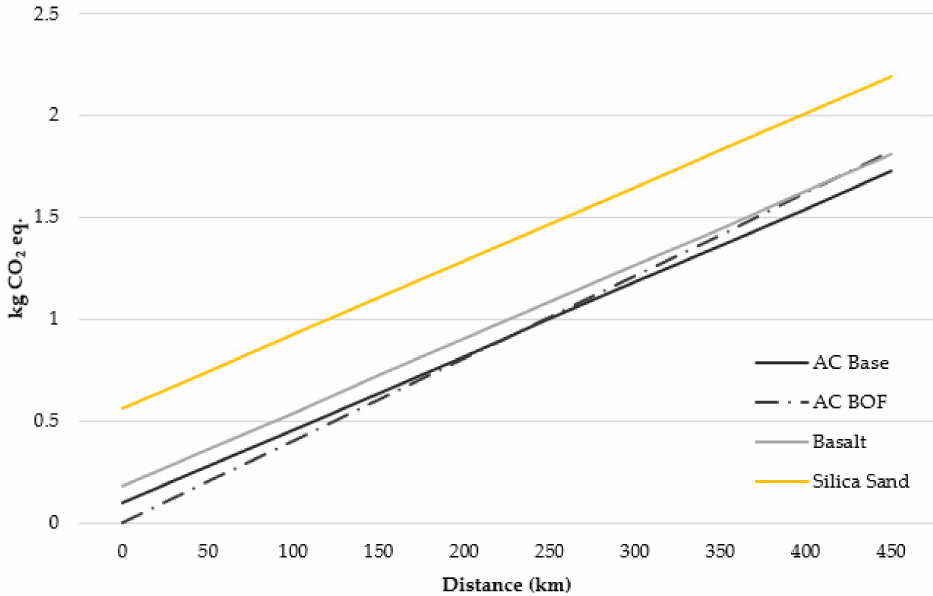
Figure 9. Sensitivity analysis for transport distances for different aggregates.